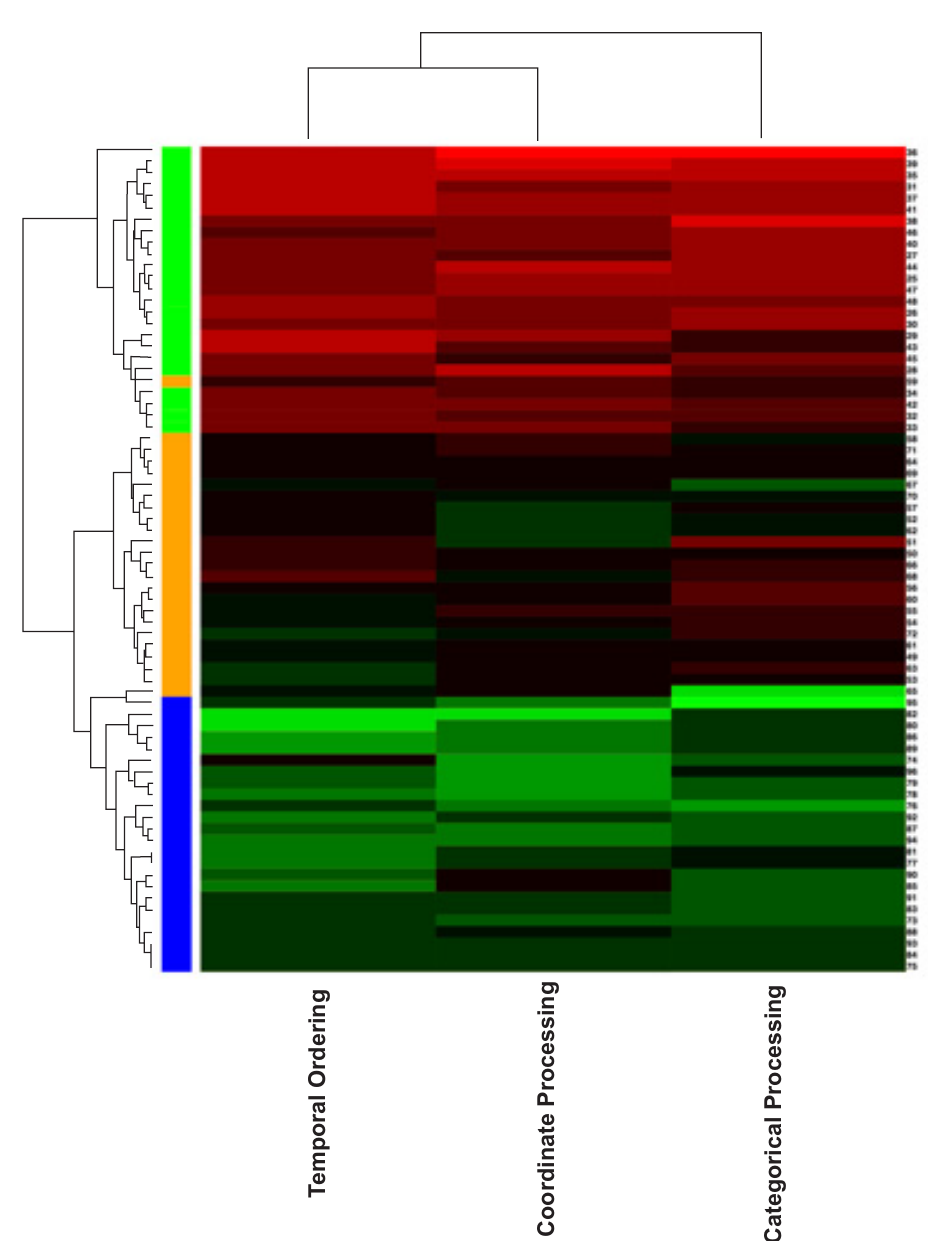
Figure 8. Heatmap visualizing unsupervised hierarchal clustering of CGG KI and Fmr1 KO mice based on overall behavioral performance. Note how the algorithm was capable of separating groups with high levels of accuracy, with only a single high CGG KI mouse being misclassified. The colors along the right hand column of the heatmap correspond to the group colors used in Figure